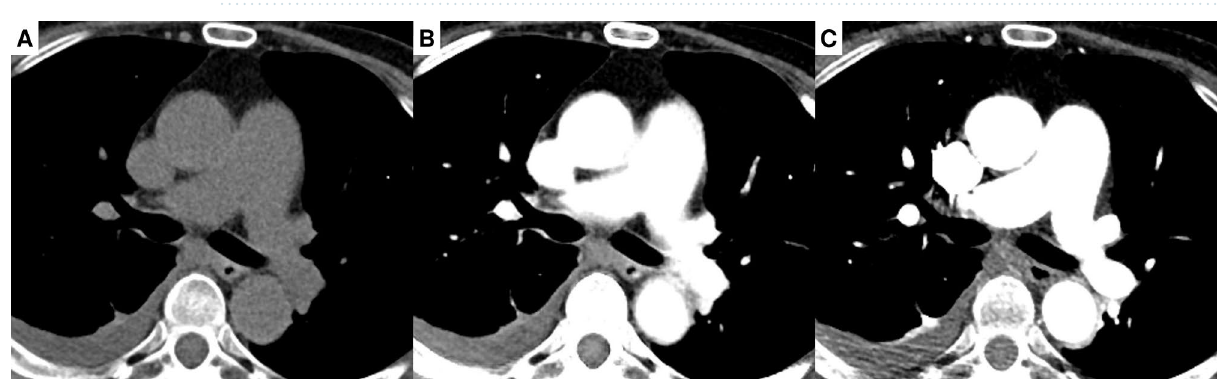
Figure 2. Images of a 63-year-old woman with right pneumothorax from the tuning set are presented. Non- contrast CT ( A ), synthetic contrast-enhanced CT ( B ), and contrast-enhanced CT ( C ).